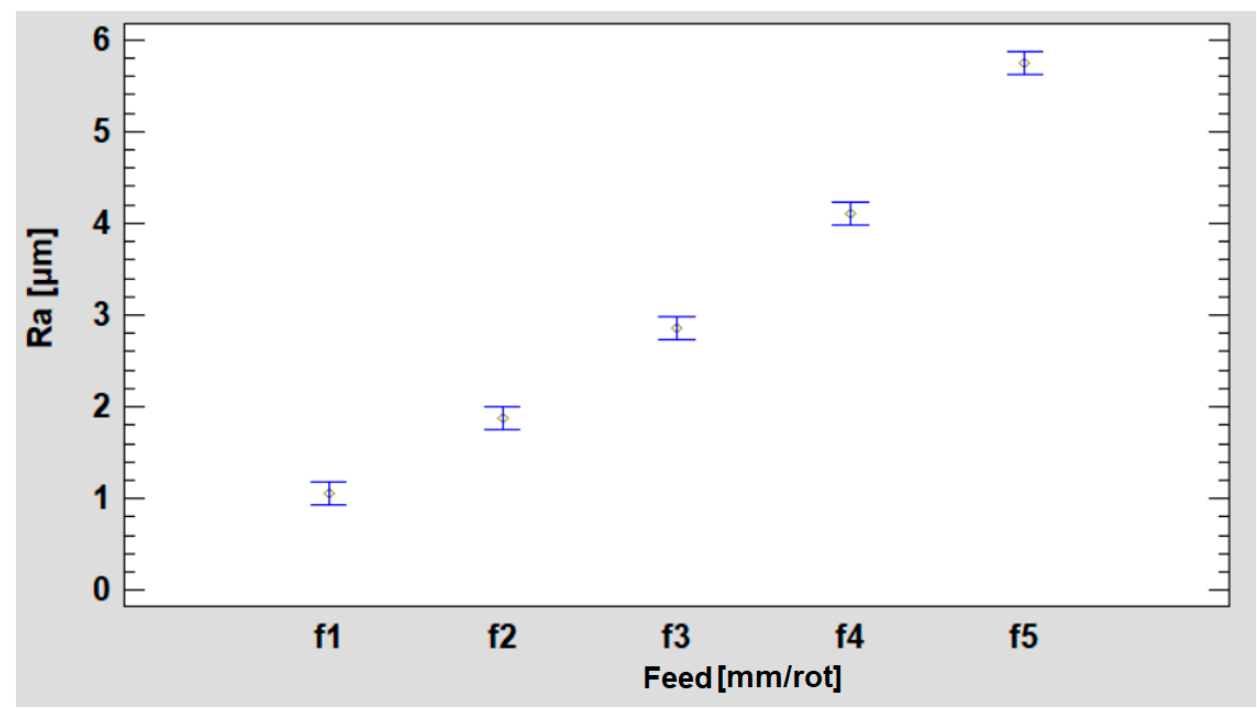
Figure 15. R a means plot of the surface after hot flux.